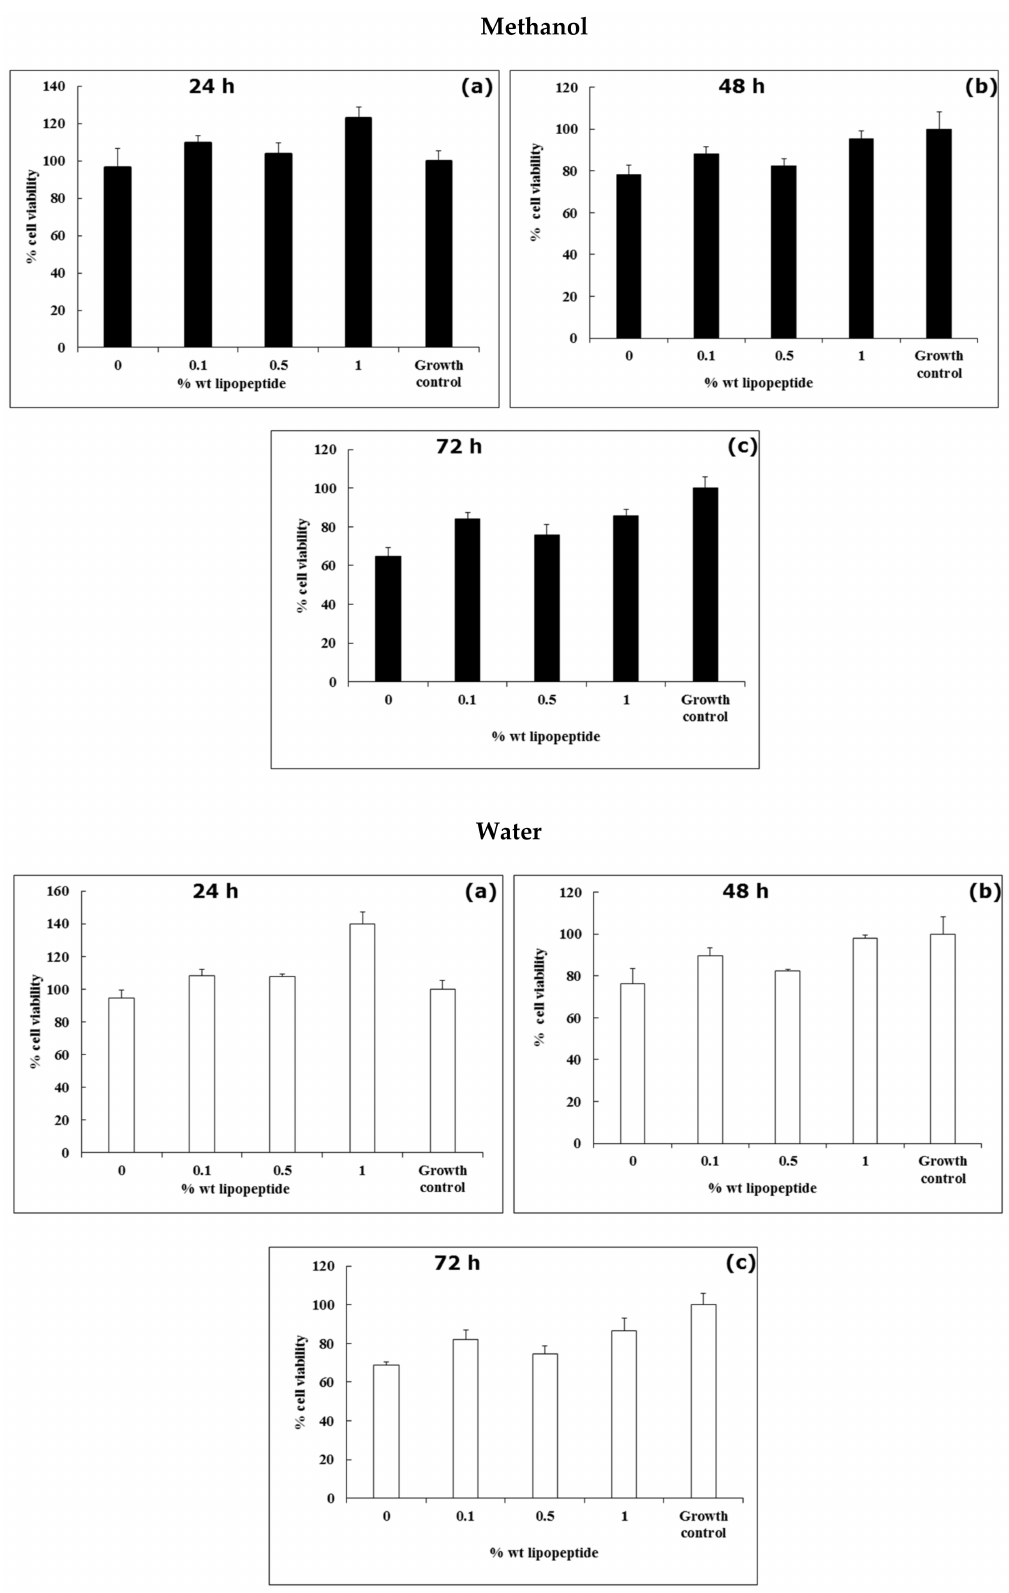
Figure 7. MTT- cell viability assay of human dermal fibroblasts treated with di ff erent content (wt%) of lipopeptide gels at di ff erent time intervals ( a ) 24 h, ( b ) 48 h and ( c ) 72